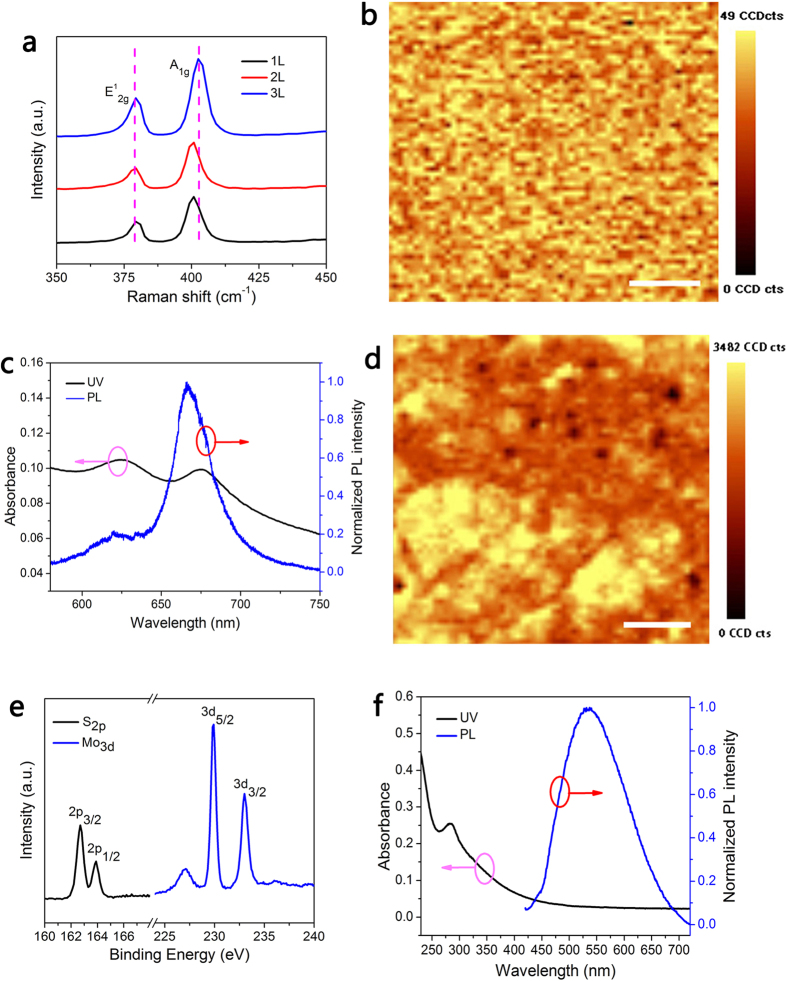
Spectroscopic characterisations of MoS2 films.(a) Raman spectra of as-grown monolayer (1L), bilayer (2L) and trilayer (3L) MoS2 on SiO2/Si substrates. (b) Raman image of the characteristic peak (A1g) integrated from 395 to 410 cm−1. Scale bar: 4 μm. (c) PL and UV-visible spectra of a multilayer MoS2 film. (d) PL image of the characteristic peak at 670 nm obtained by integrating from 610 to 710 nm. Scale bar: 4 μm. (e) X-ray photoelectron spectroscopy (XPS) spectra of a thin MoS2 film. (f) PL and UV-visible spectra of GQDs.